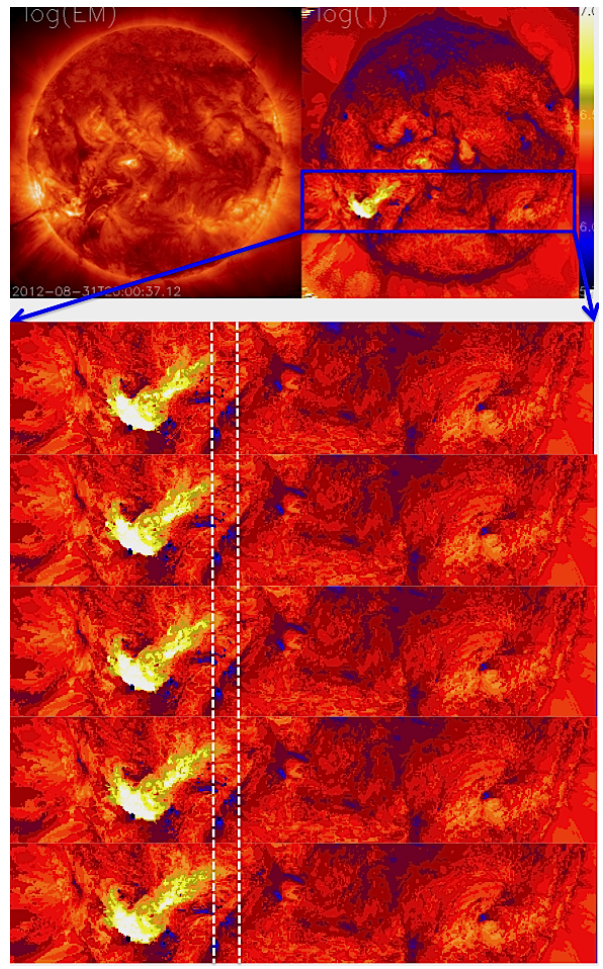
Figure 3. Snapshots at different times of the region where the heat front is